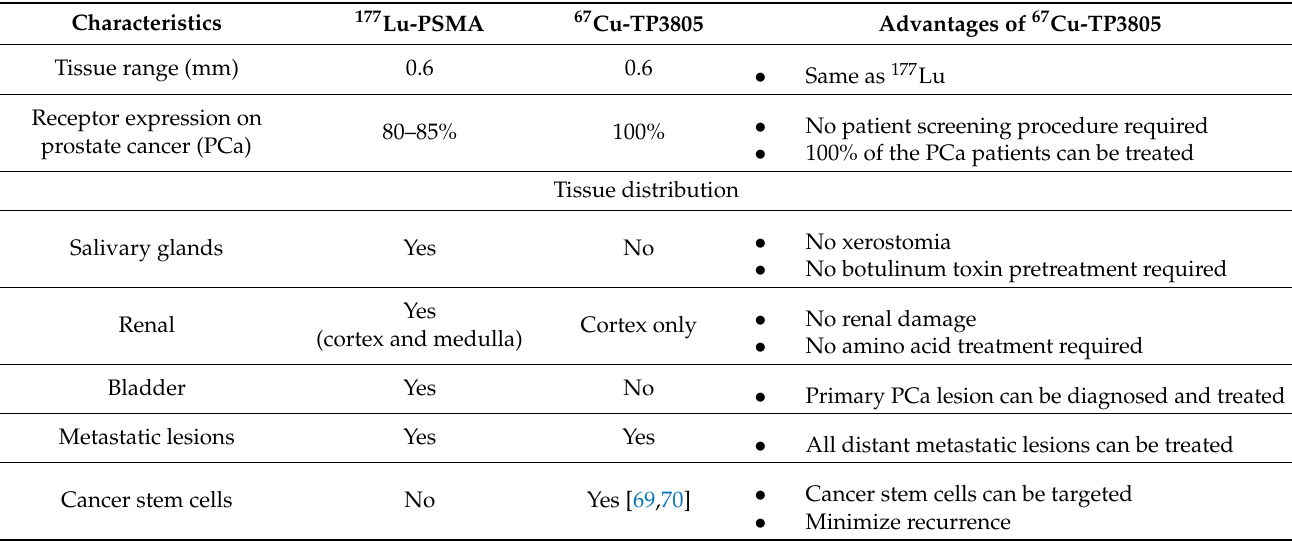
Table 4. Comparing theragnostic characteristics of 67 Cu-TP3805 with 177